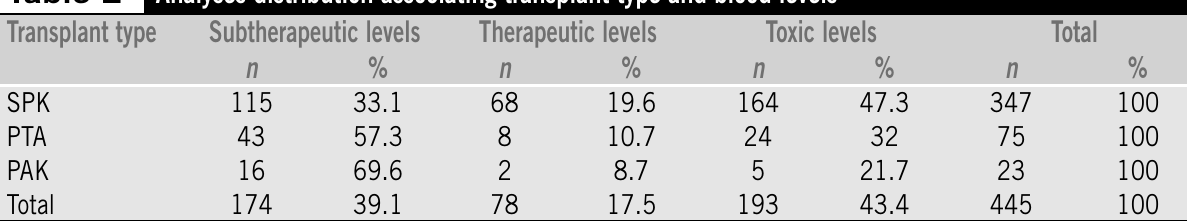
Table 2 Analyses distribution associating transplant type and blood levels Transplant type